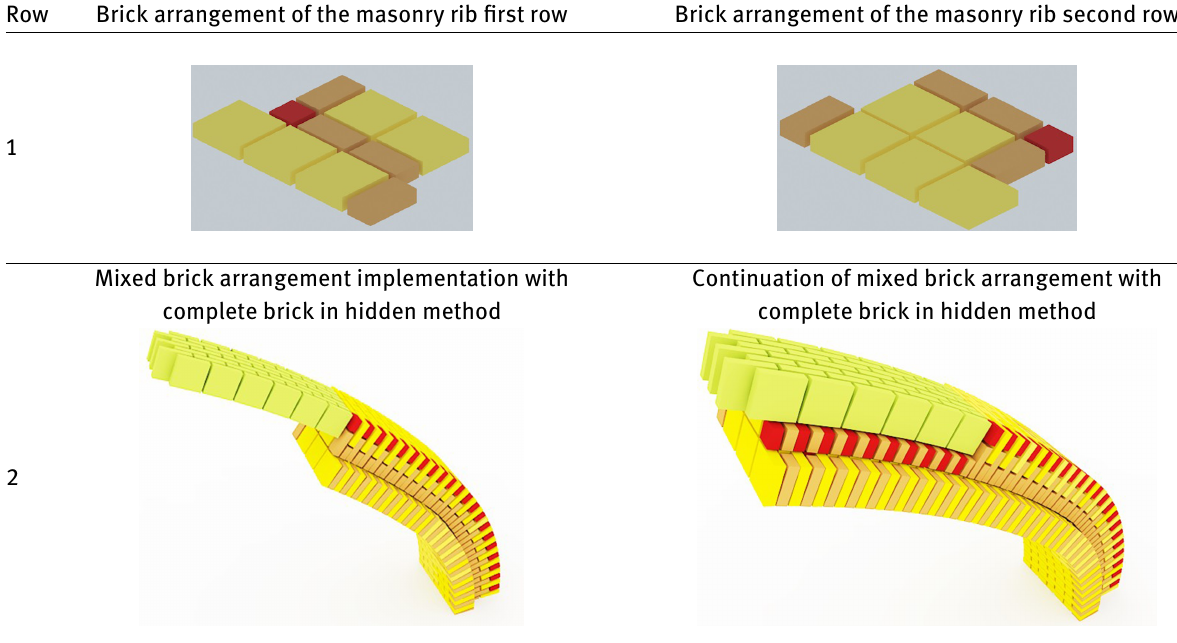
Table 4: Perspective and photo of implementation of masonry rib with mixed brick arrangement method in Tabriz